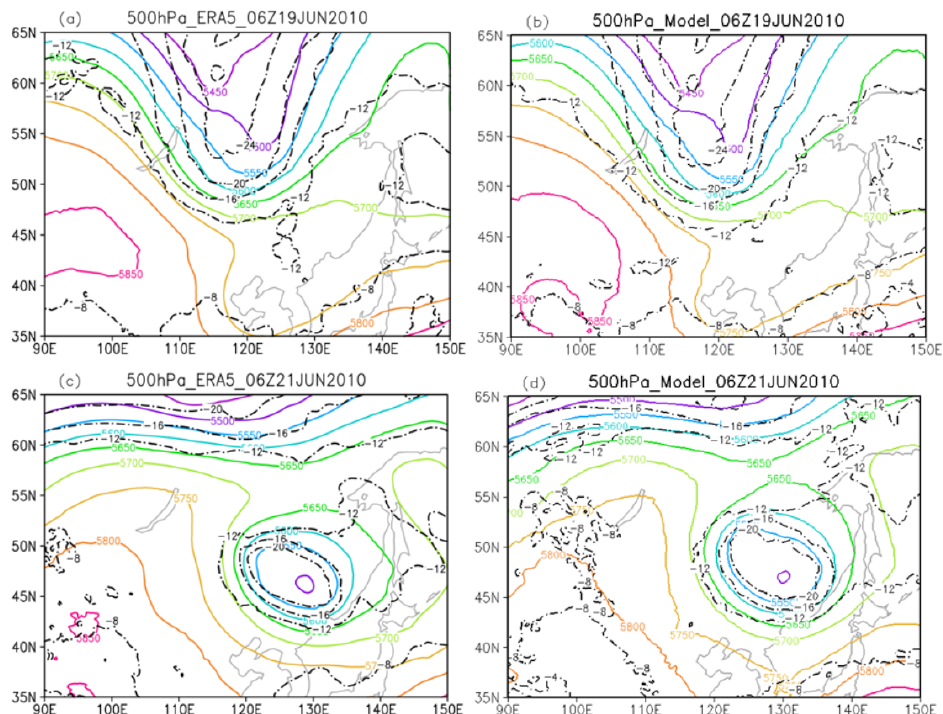
Figure A2. The 500 hPa geopotential height (solid lines, unit: gpm) and temperature (dash–dot lines, unit: ◦ C) from the ERA5 data ( a , c ) and the simulation ( b , d ), at 06:00 UTC on 19 June, and at 06:00 UTC on 21 June, respectively.